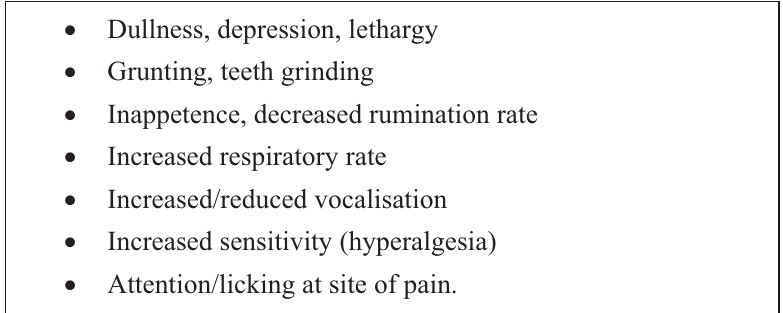
Table 2. Identification of pain in cattle and